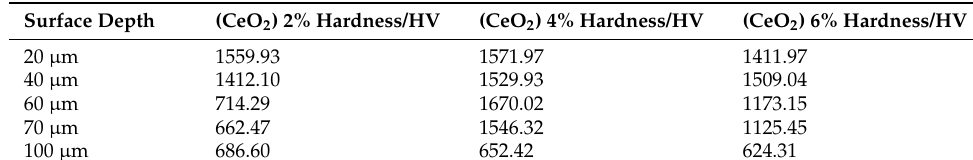
Table 6. Boronizing layer hardness (boronizing temp. 950 ◦ C, time 4 h). Surface Depth